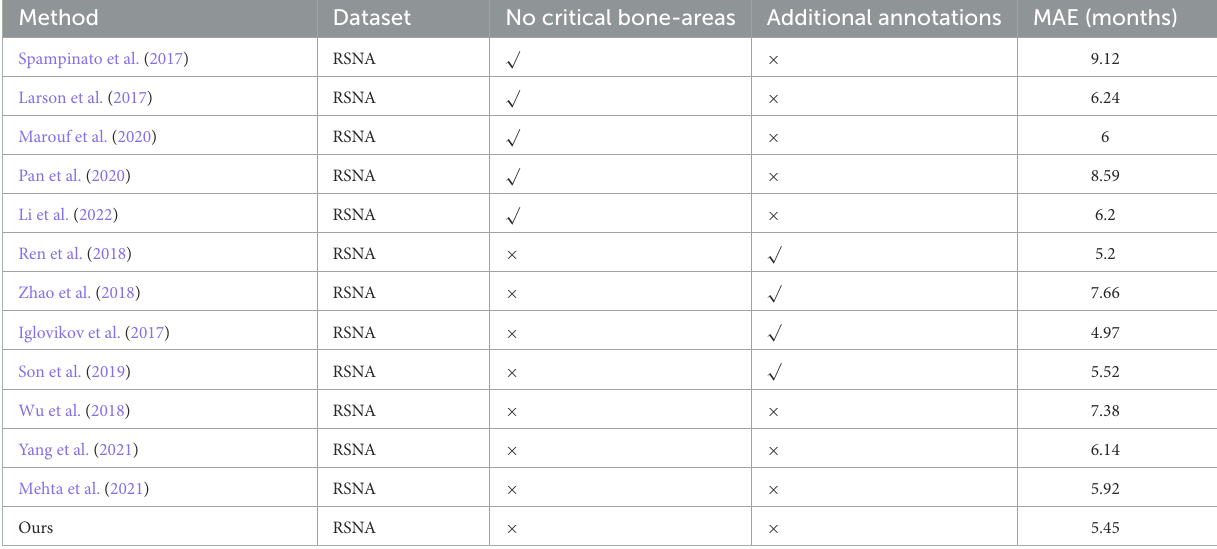
TABLE 1 The results of comparison with other methods on RSNA dataset.